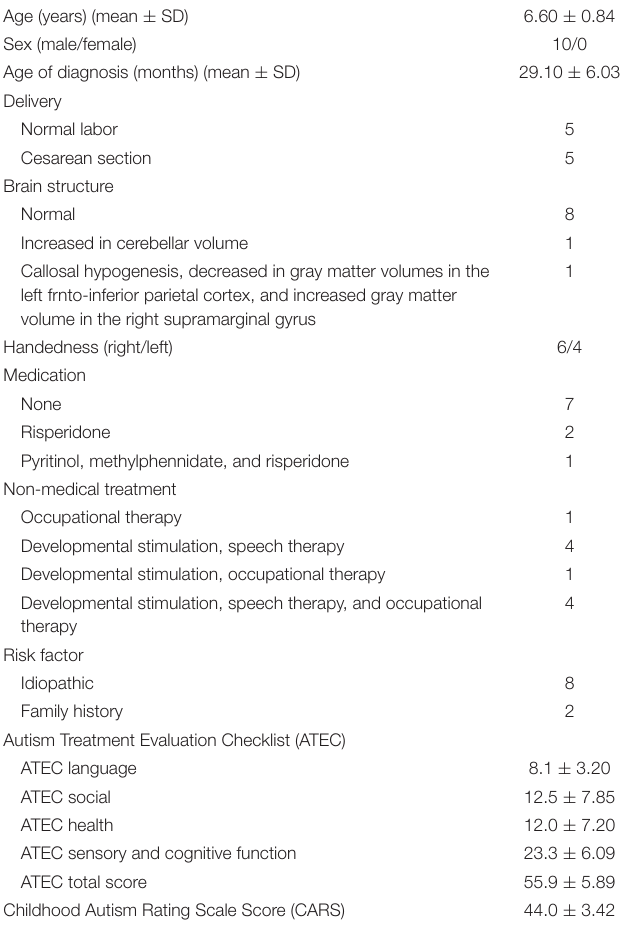
TABLE 1 | Demographic data of participants ( n =